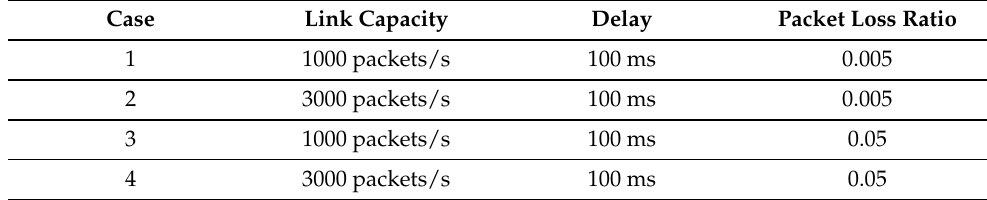
Table 2. Network parameters for different cases.